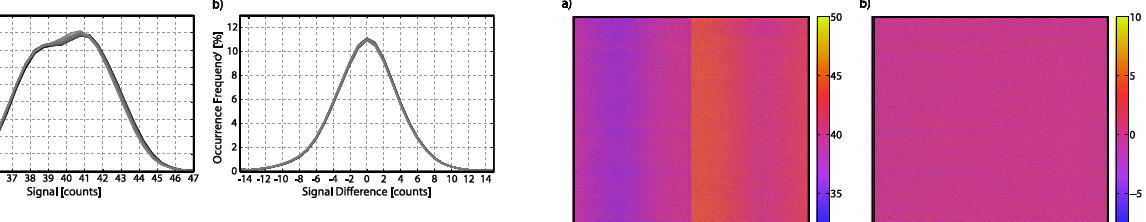
(I,t) as a function of pixel ij